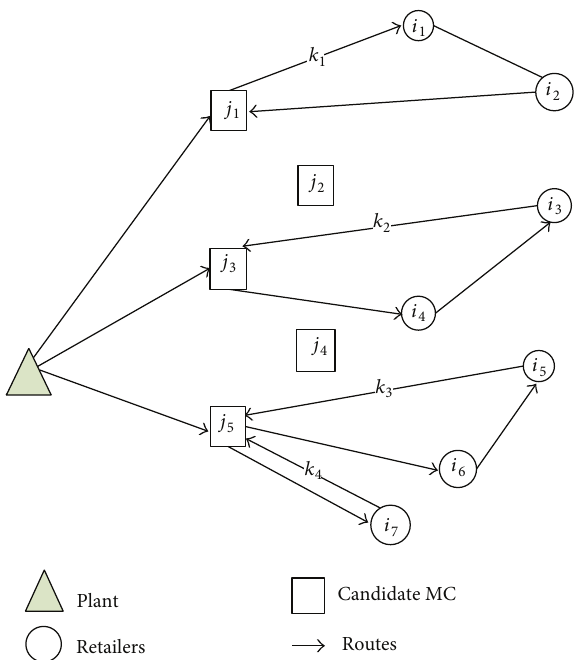
Figure 1: Diagram of the LIRP